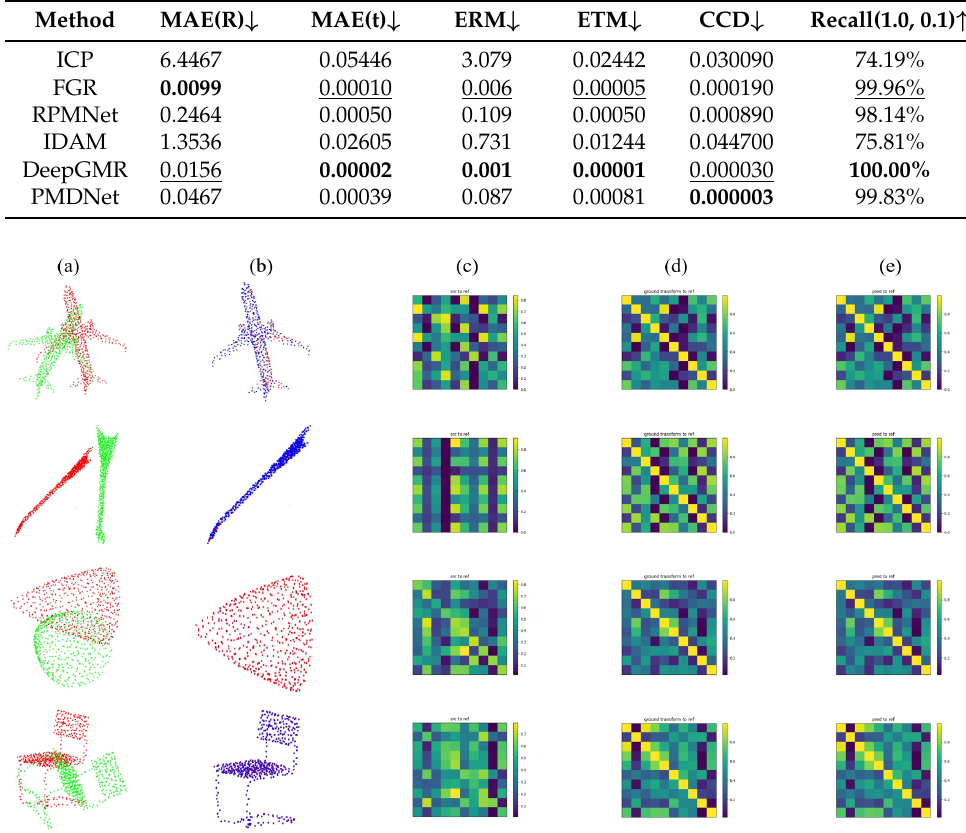
Figure 6. Qualitative results of the PMDNet on clean data. ( a ) source and reference clouds. ( b ) ref- erence and predicted clouds. ( c ) correspondence between source and reference. ( d ) ground-truth correspondence. ( e ) correspondence between predicted and reference